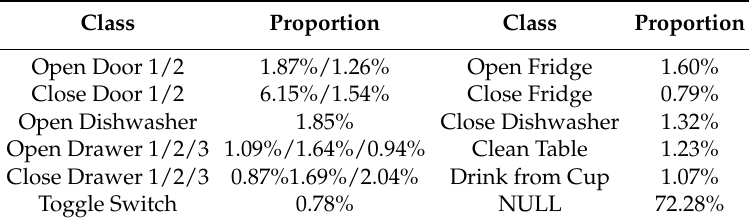
Table 4. Classes and proportions for the OPPORTUNITY dataset.